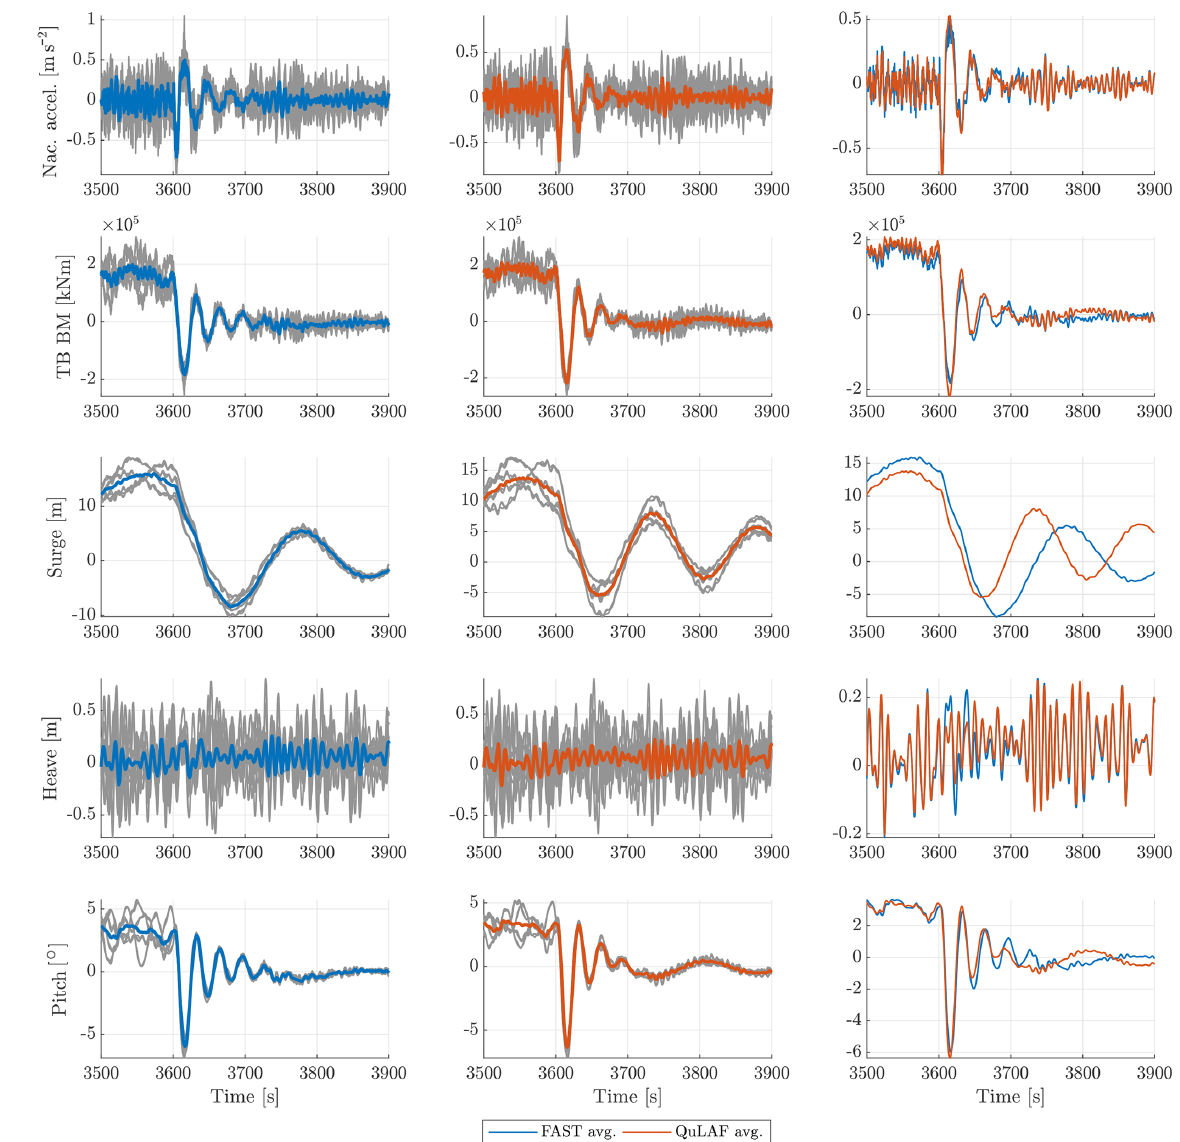
Figure 7. Zoomed time series of DLC 2.1 with a mean wind speed of 13 . 9ms − 1 for FAST and QuLAF. The average responses are obtained based on the four different wave and wind seeds and three realizations of the peak period.